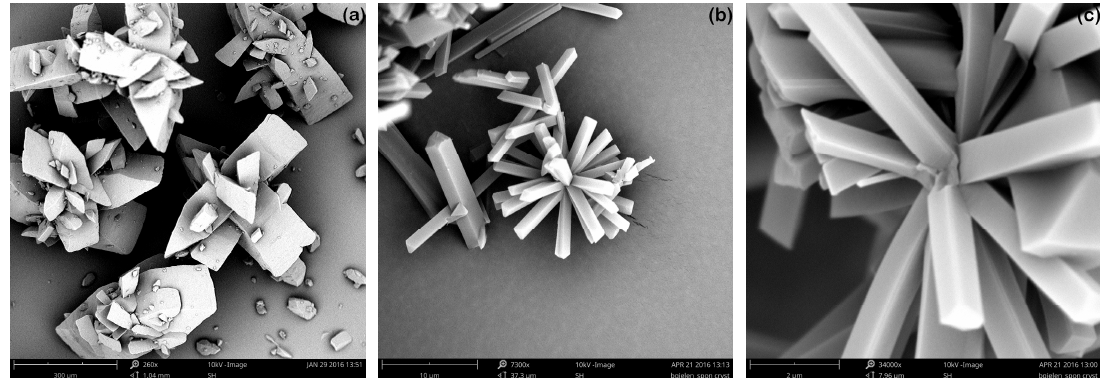
Figure 4. SEM images of the API produced by the conventional crystallization process in the Easymax 102 setup with addition of 0.2 m% dry seed material at 62 °C. The crystal were imaged after filtration at 15 °C and air drying. Crystals were taken at different magnifications, given by the length of the scale bar: ( a ) 300 µm; ( b ) 10 µm; and ( c ) 2 µm.